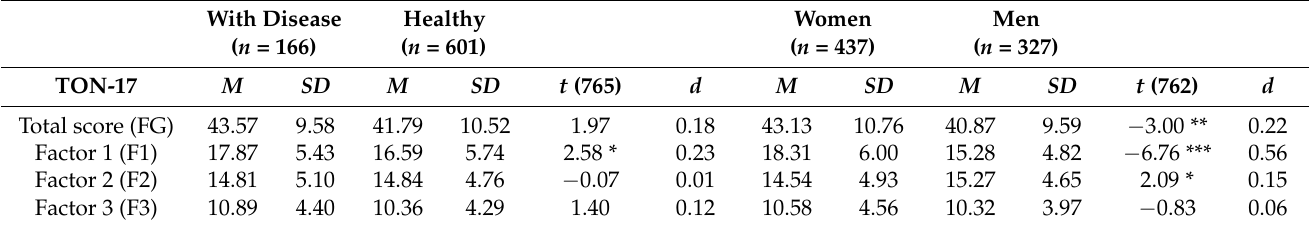
Table 5. Differences in ON between female and male participants, and people with a disease that require a restrictive diet and those without health problems.